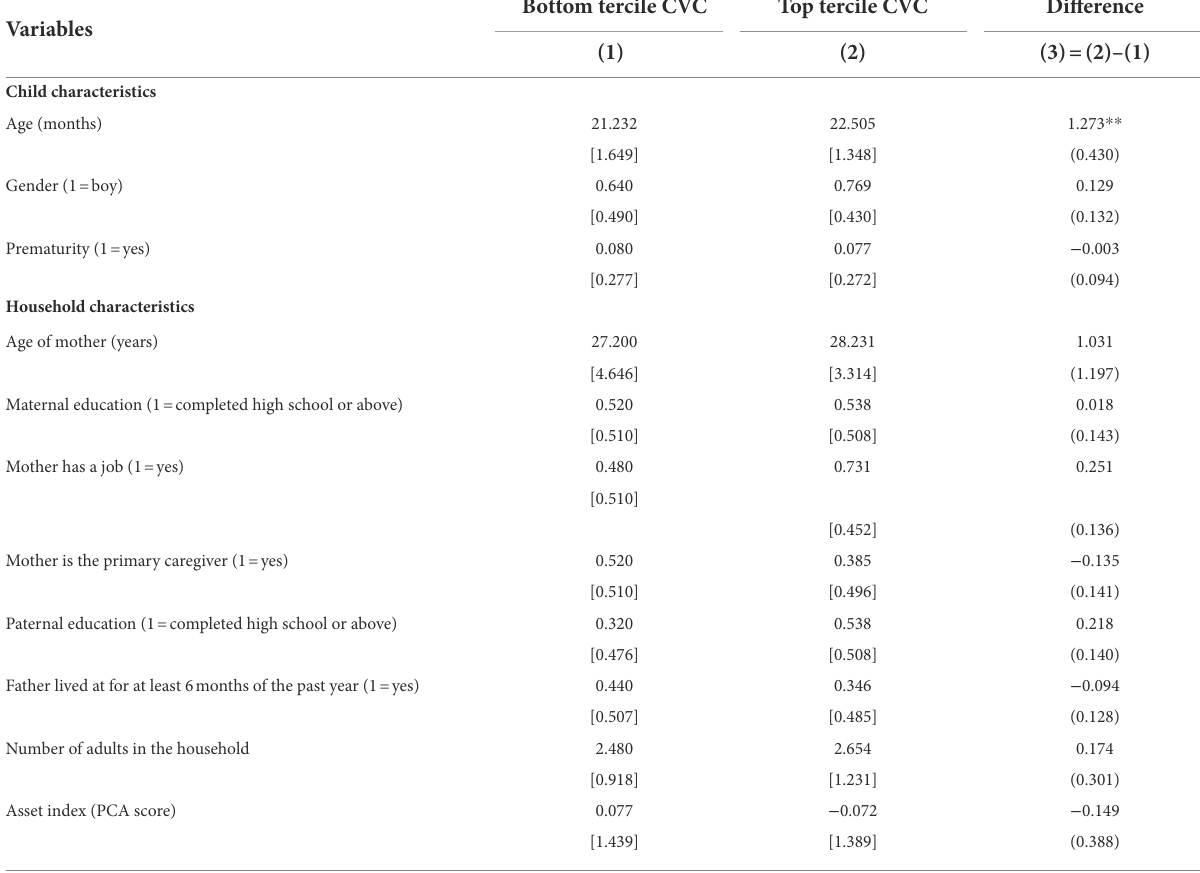
TABLE 4 Differences in demographic characteristics between top and bottom terciles of Child Vocalization Count